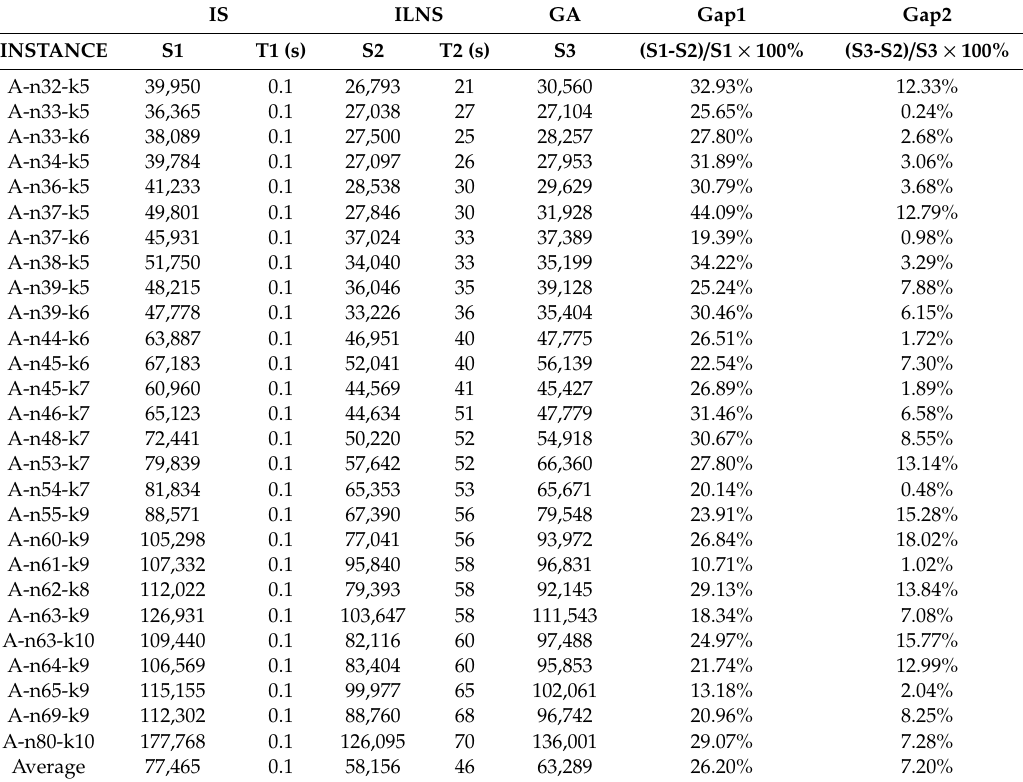
Table 2. Computational results of four algorithms for group A. IS—initial solution; GA— genetic algorithm.